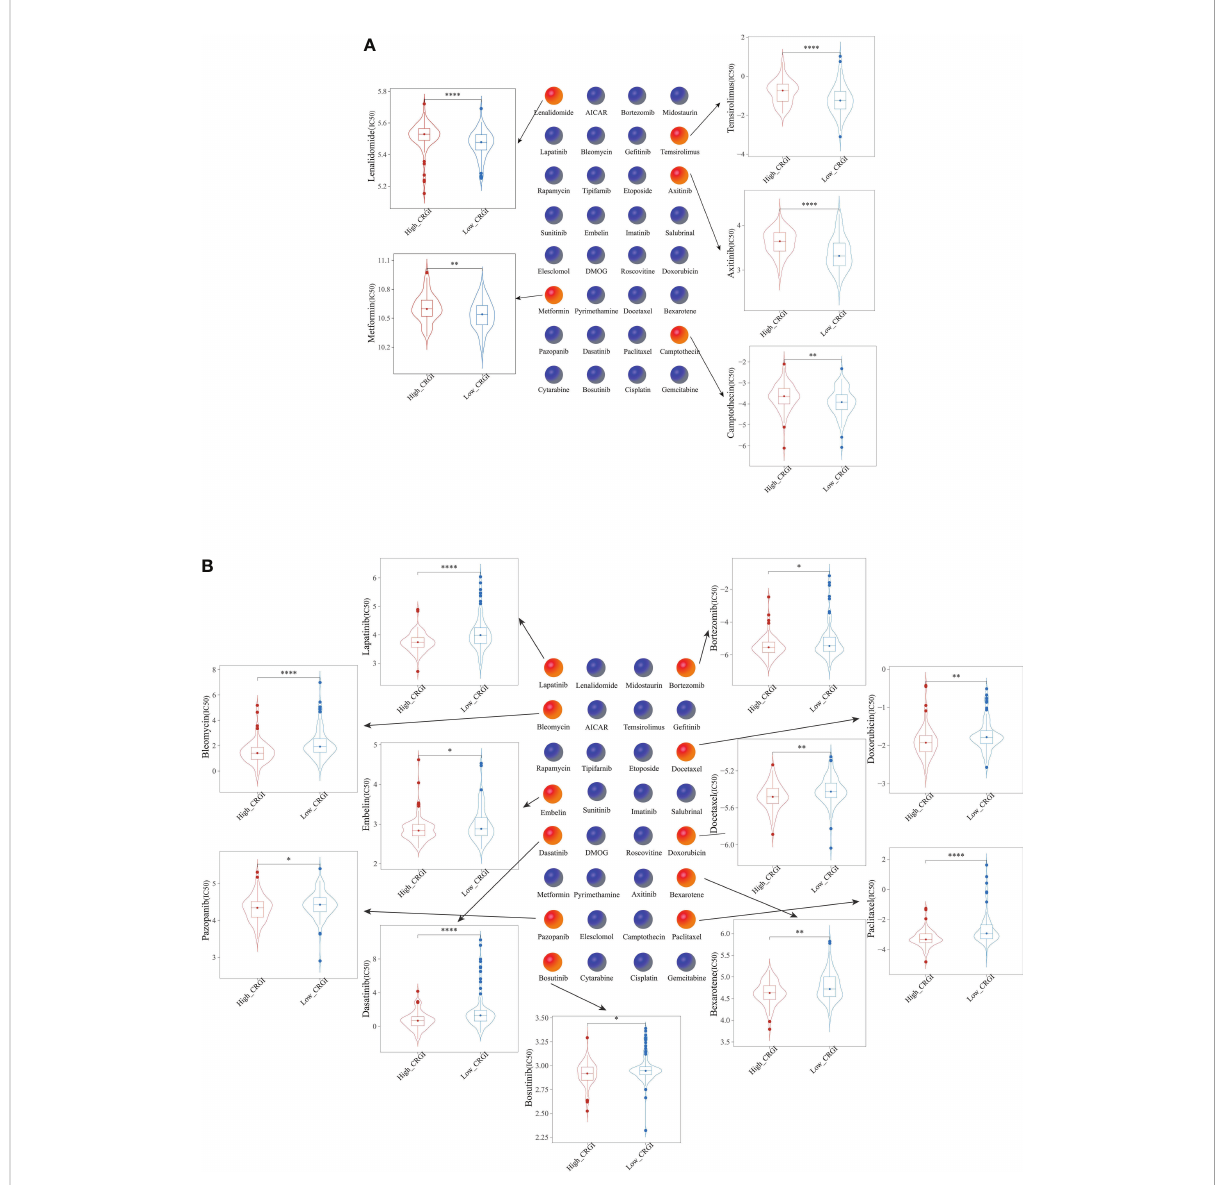
FIGURE 7 Comparison of the ef fi cacy of 32 chemotherapeutics in (A) high-CRGI group, and (B) low-CRGI group. *, **, ***, and **** indicate the P-value thresholds 0.05, 0.01, 0.001, and 0.0001,